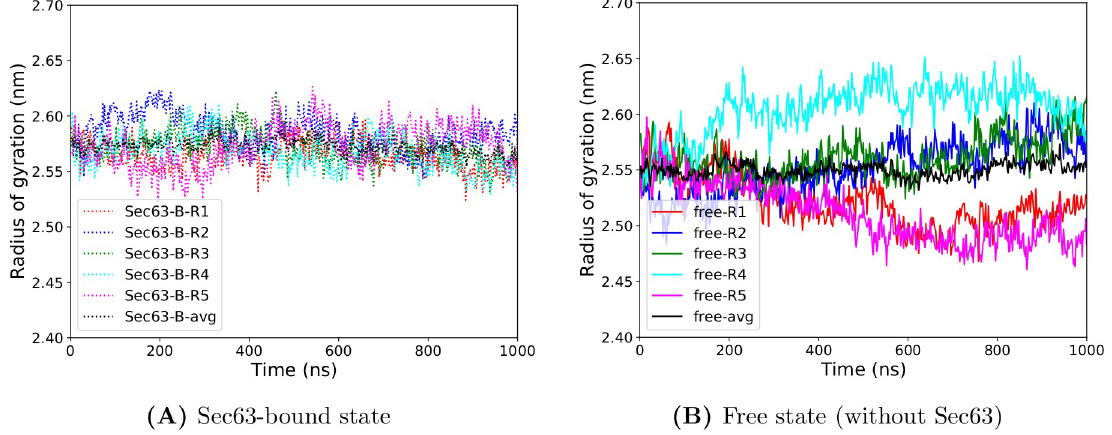
Fig 3. Time dependence of the radius of gyration (R g ) of Sec61 obtained from five independent MD simulations (Ri, i = replica number). (A) Sec63-bound state (B) Free state (without Sec63).